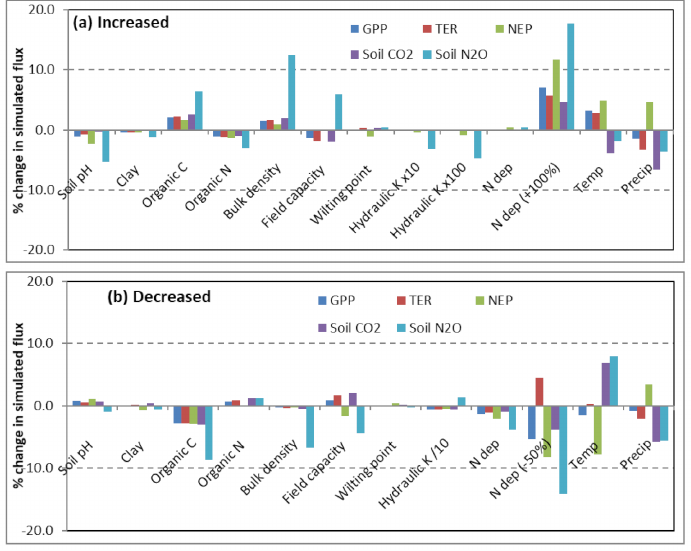
Figure 6. Sensitivity tests showing % change in simulated annual CO 2 and N 2 O fluxes with input values ( a ) increased by 10% and ( b ) decreased by 10% (except pH: changed by 1 unit, soil hydraulic conductivity: changed as shown, and N dep: ± 10% and +100% or − 50% change). Simulations using PnET